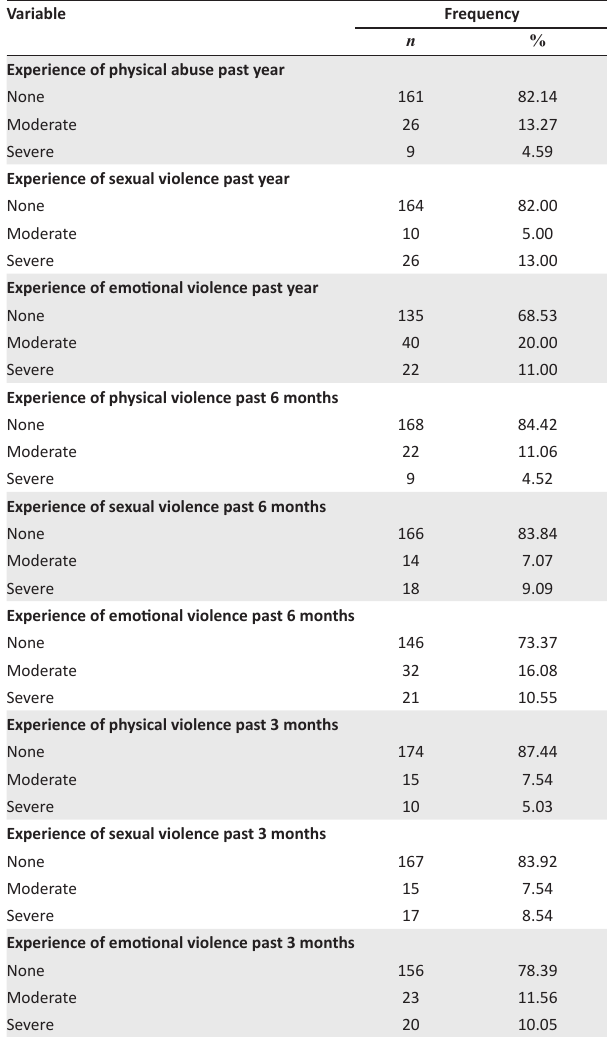
TABLE 4: Frequency of experiencing severity of physical, emotional and sexual